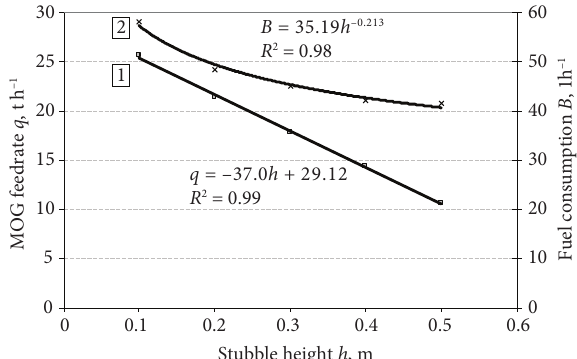
Figure 3. Effect of stubble height of WOSR Visby ( h ) on the quantity of straw fed to combine harvester B ( q ) and on the hourly fuel consumption ( B ) when the biological straw yield A 1 = 10.8 t ha −1 , seed yield A g = 4.9 t ha −1 , U 1 = 8.7%, and MOG = 68.8%. (1) represents the MOG mass fed to the harvester ( q ; t h −1 ), and (2) represents hourly fuel consumption ( B ; l h −1 )